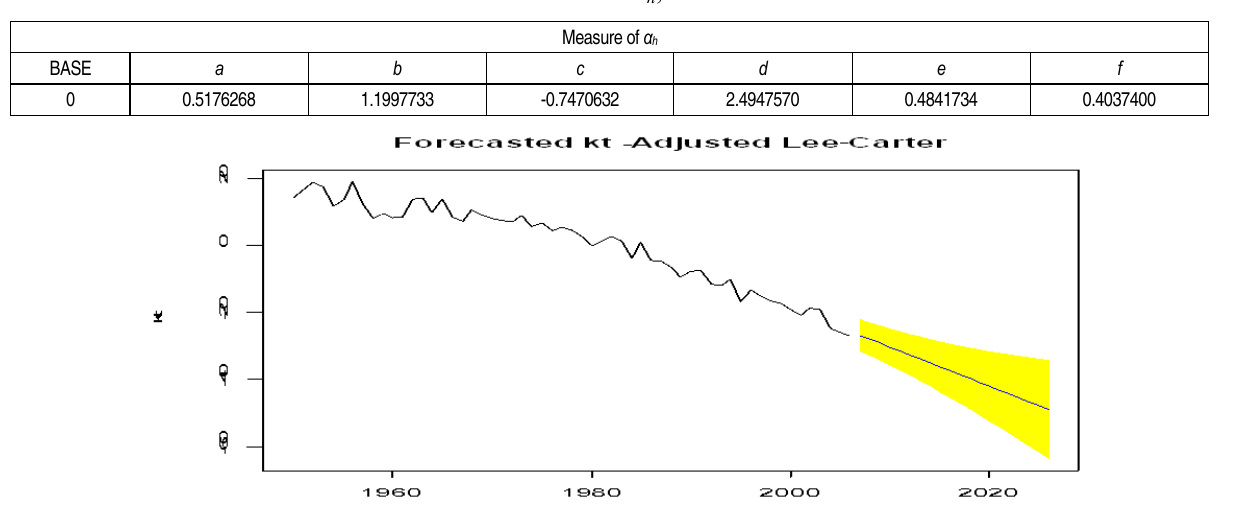
Table 2. Measure of α